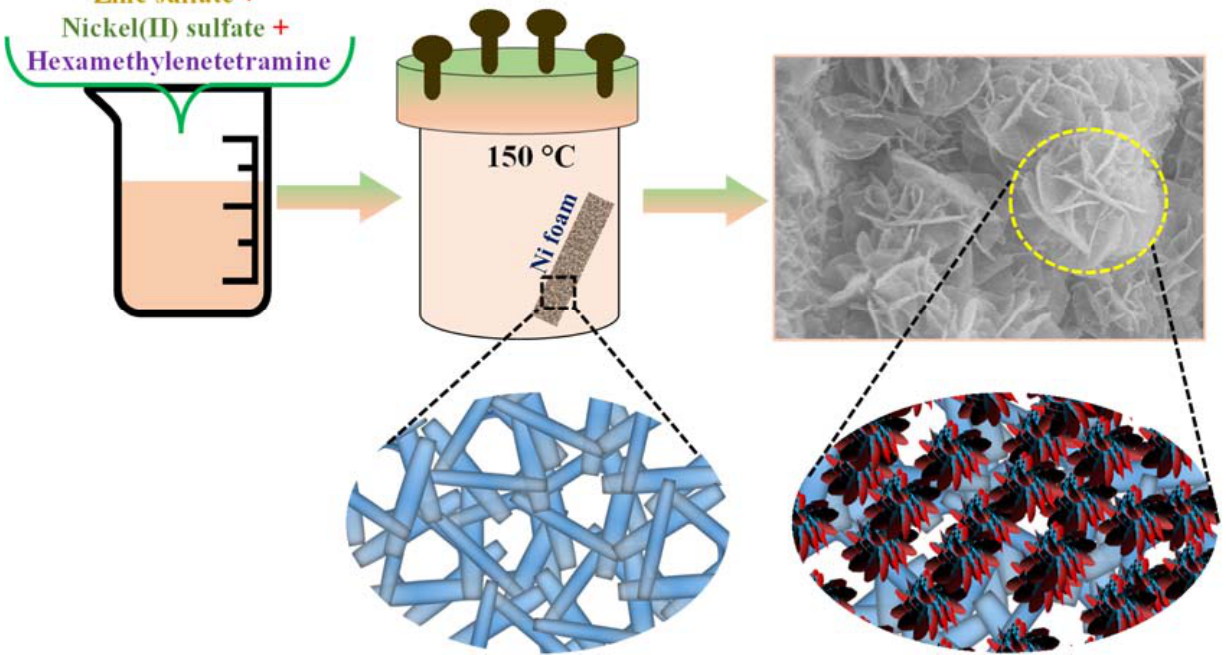
Figure 1. Schematic illustration of the synthesis of binder ‐ free NiZn 2 O 4 @3D ‐ NF.